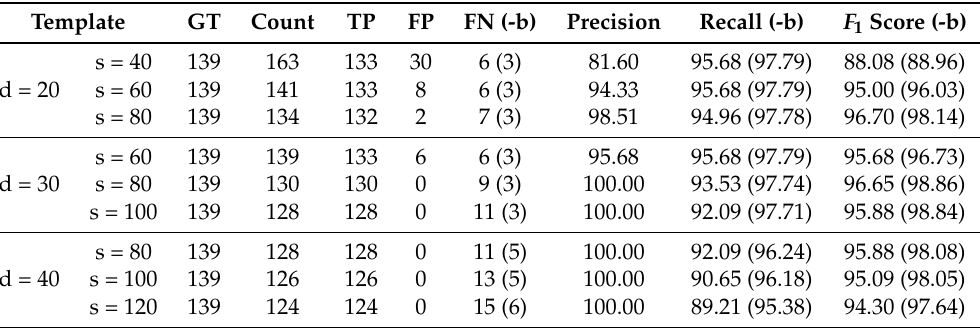
Table 3. Classification performance metrics with different template sizes (d, s) for image DJI_0232 (d: diameter, s: side size, GT: ground-truth, TP: true positive, FP: false positive, FN: false negative, (-b): excluding errors in the borderline).